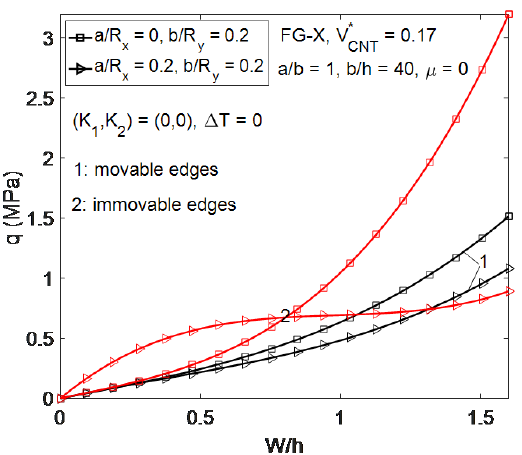
Fig. 3: Comparison of nonlinear response of FG-CNTRC cylindrical and spherical panels under uniform external pressure.